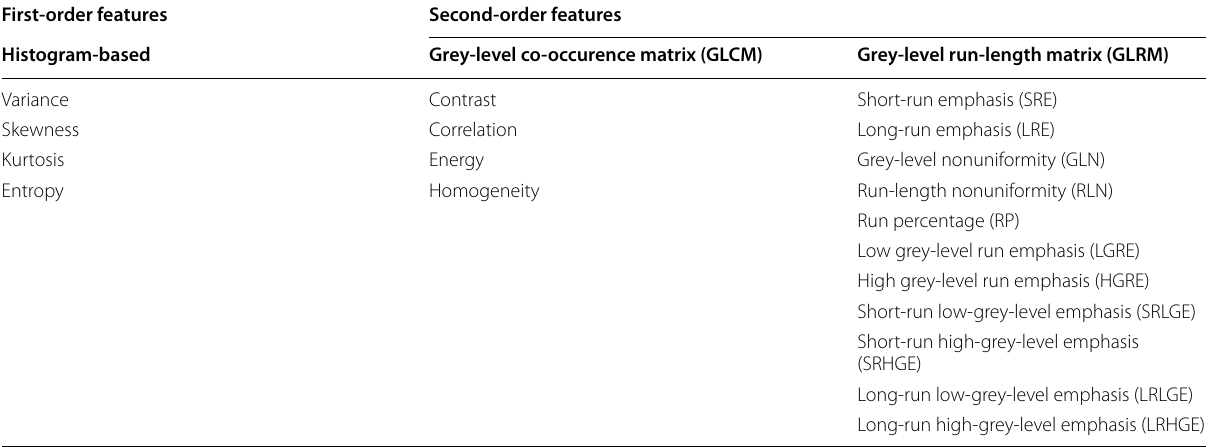
Table 1 Overview of texture features analysed for each image First‑order